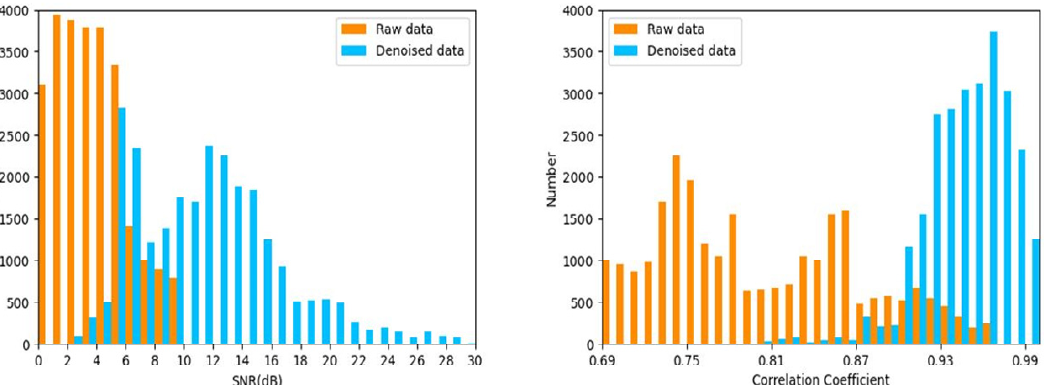
Figure 7. Improvement of the SNR and correlation coefficient in test set.